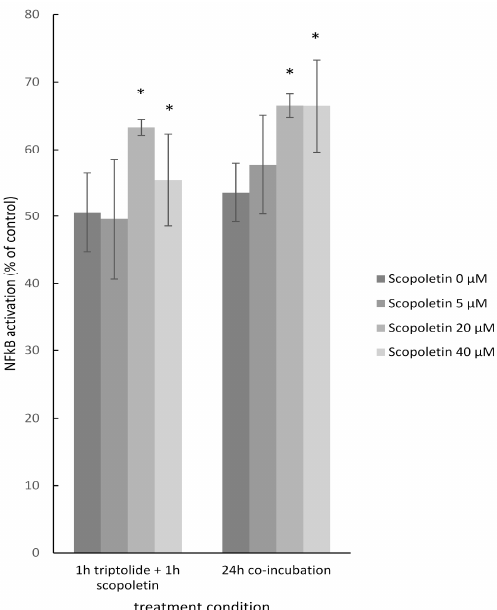
Figure 9. Effect of triptolide and scopoletin on NF- κ B activity. 1.6 nM triptolide and various concentrations of scopoletion (0 µ M, 5 µ M, 20 µ M or 40 µ M) were treated in two different conditions; 1 h triptolide treatment and then 1 h scopoletin treatment, 24 h co-incubation of triptolide and scopoletin. Quantification was carried out according to the untreated control and experiments were performed three times. (Significantly different according to Student’s t -test, * p -value < 0.05).